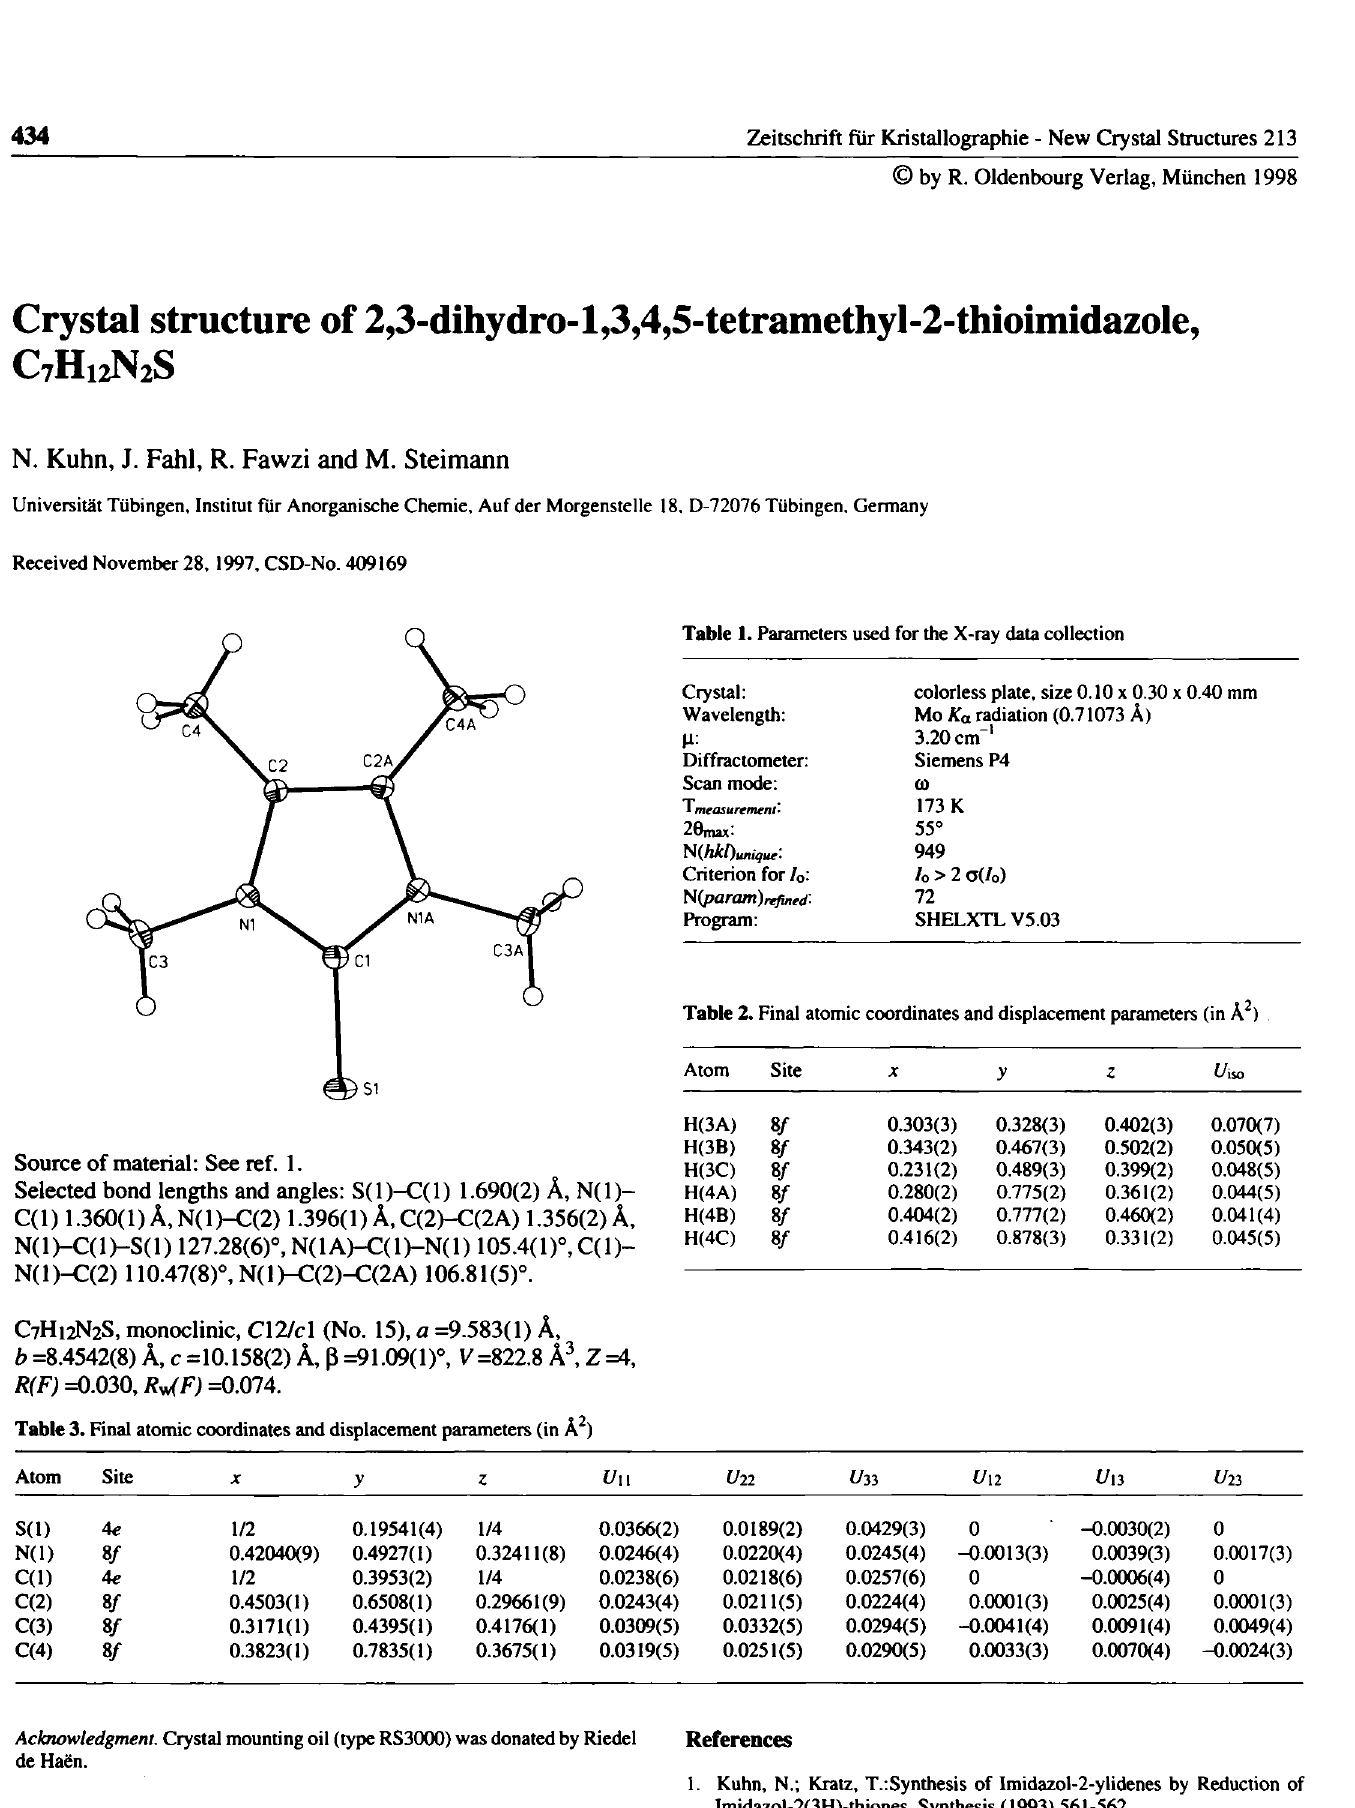
Table 3. Final atomic coordinates and displacement parameters (in